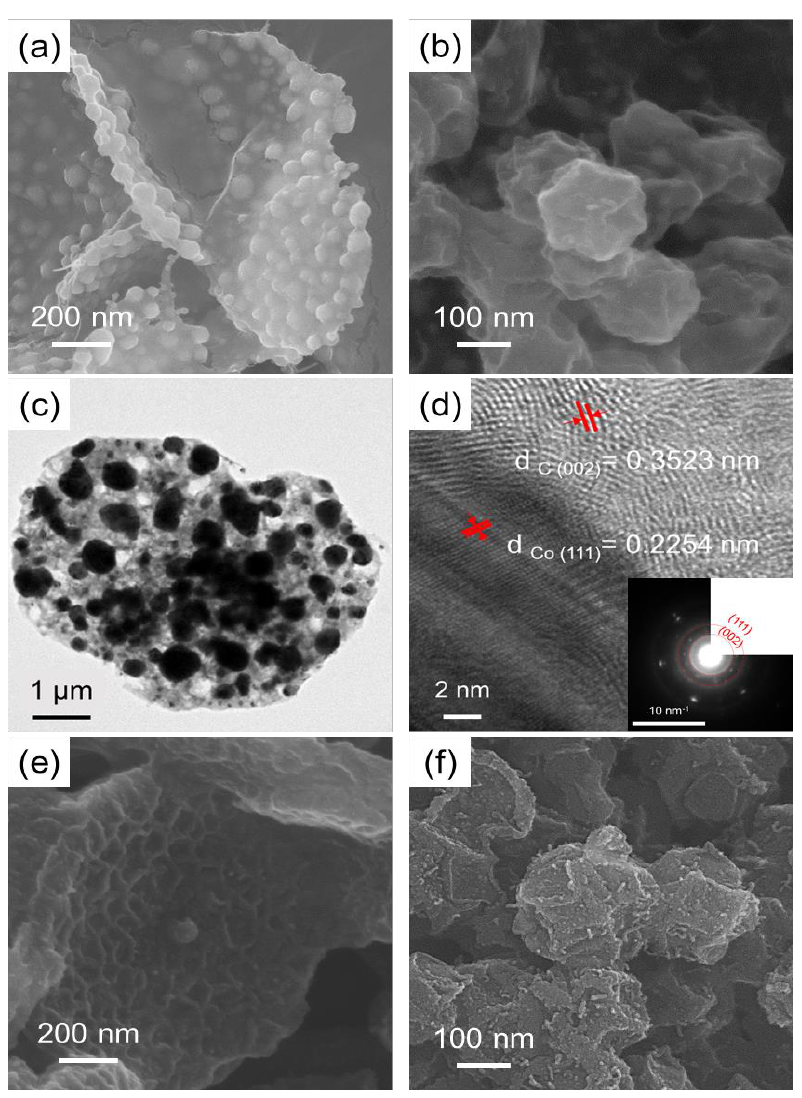
Figure 2. SEM images of ( a ) C M/L/M ; ( b ) C Co-MOF ; FEG-TEM image of ( c ) C M/L/M and ( d ) the magnified FEG-TEM image with SAED in the inset; ( e ) WNPC and ( f ) nanoporous carbon (NPC).